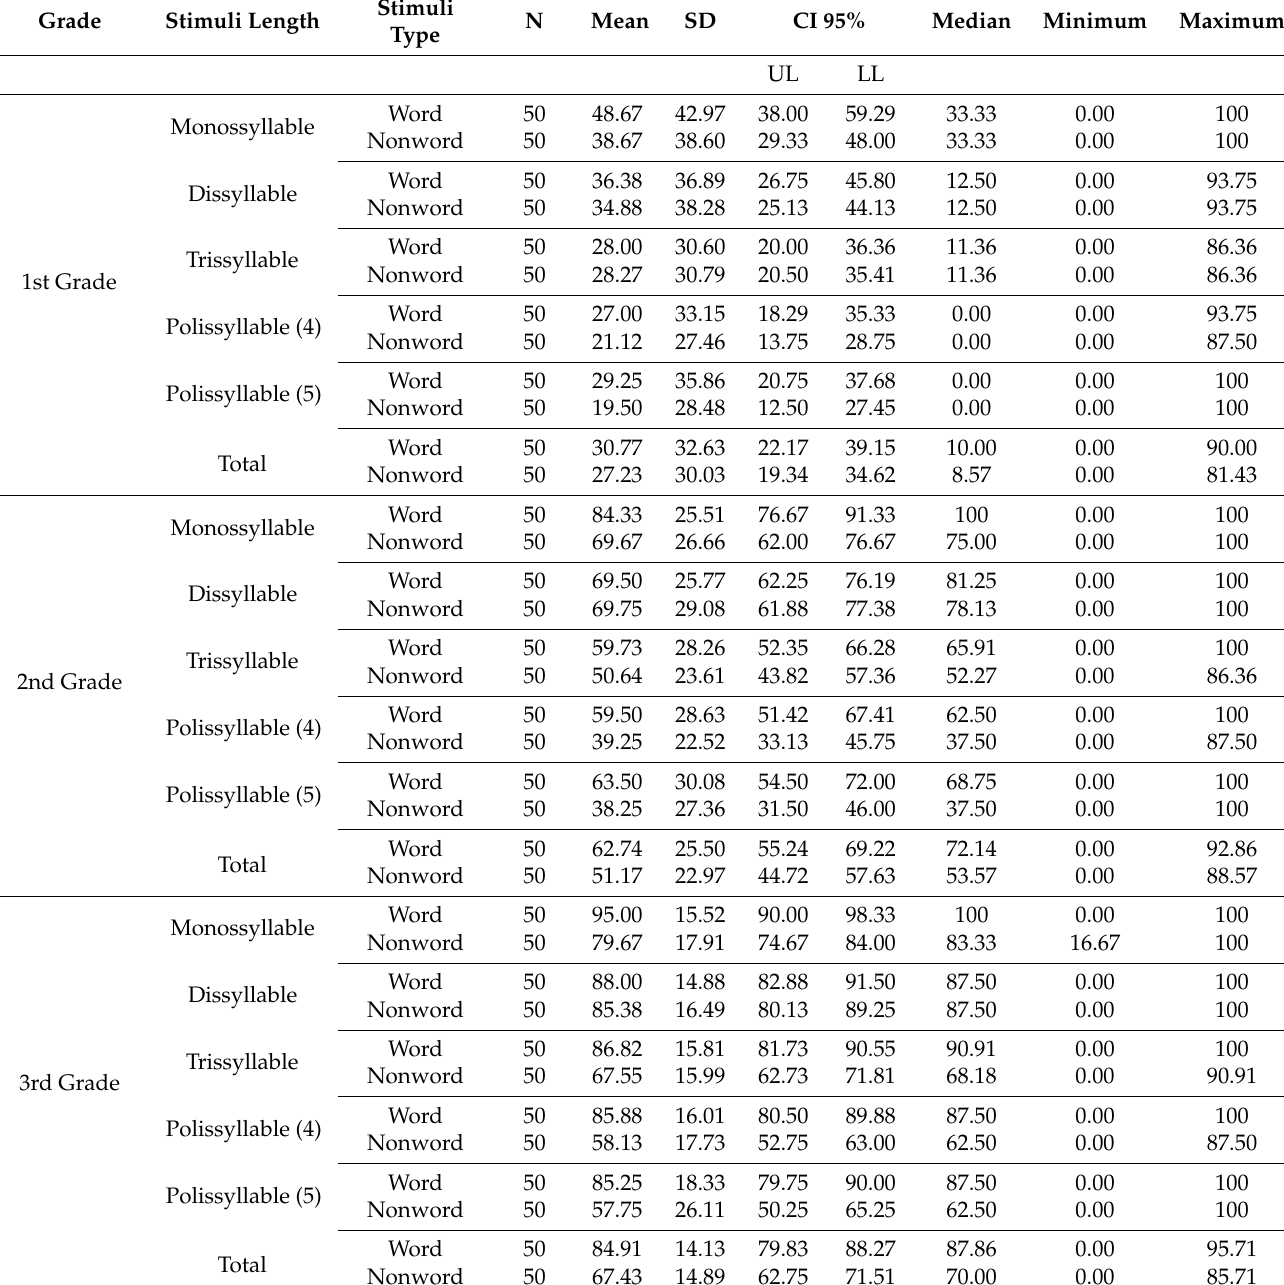
Table 2. Descriptive values of percentage accuracy according to grade and stimuli type and